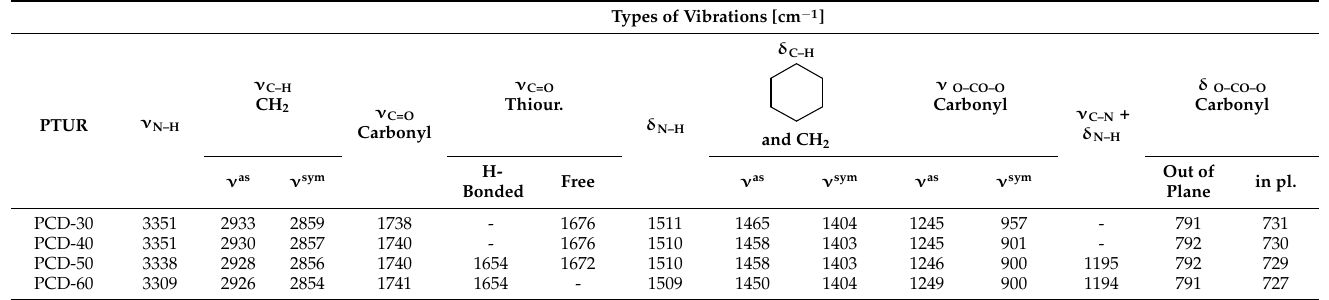
Table 2. Basic absorption bands appearing for the FTIR spectra of the obtained PTURs. Types of Vibrations [cm − 1 ]